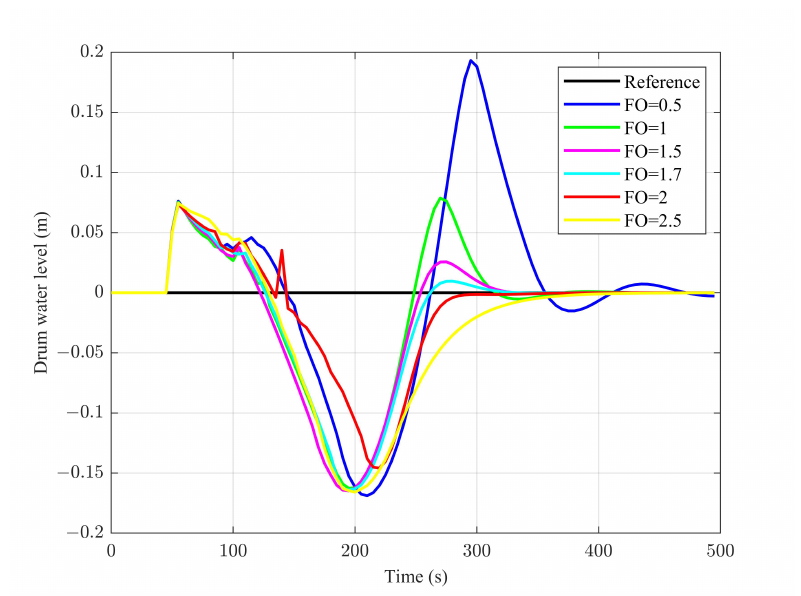
Figure 5. The drum water level with different fractional